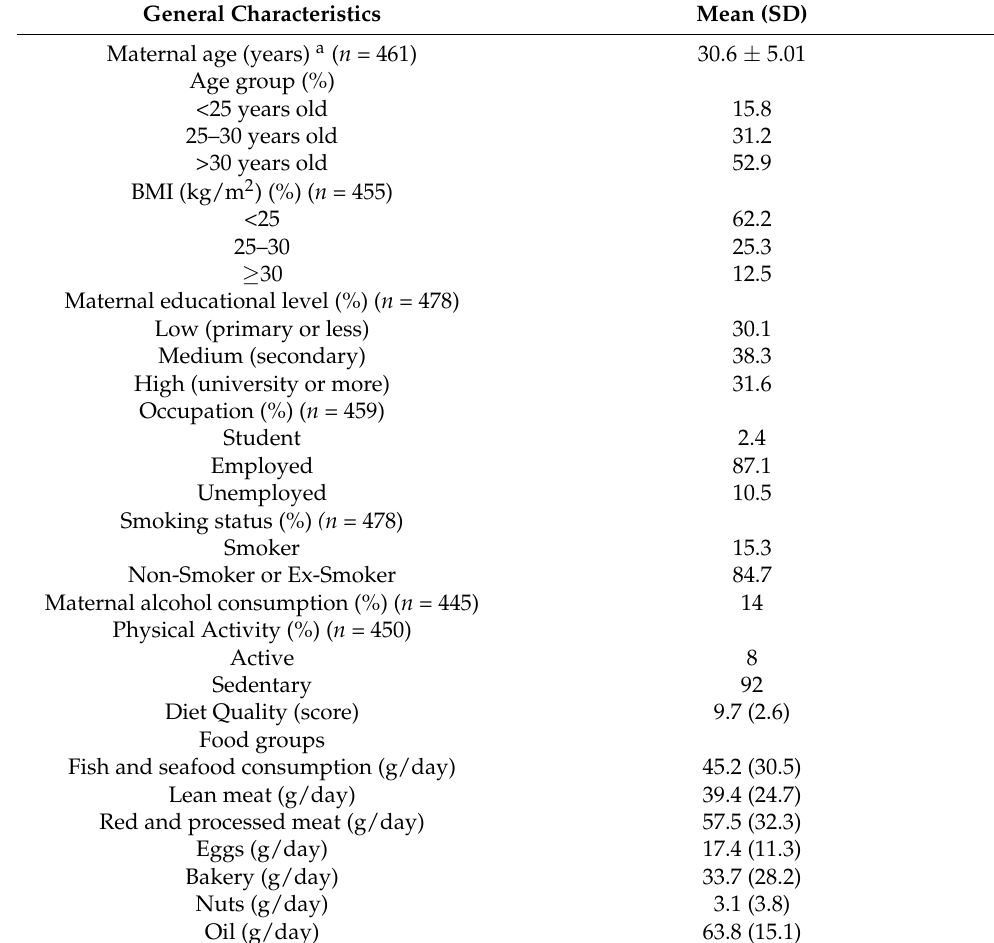
Table 1. Sociodemographic and lifestyle of pregnant women at baseline and fatty acid biochemical profile at first